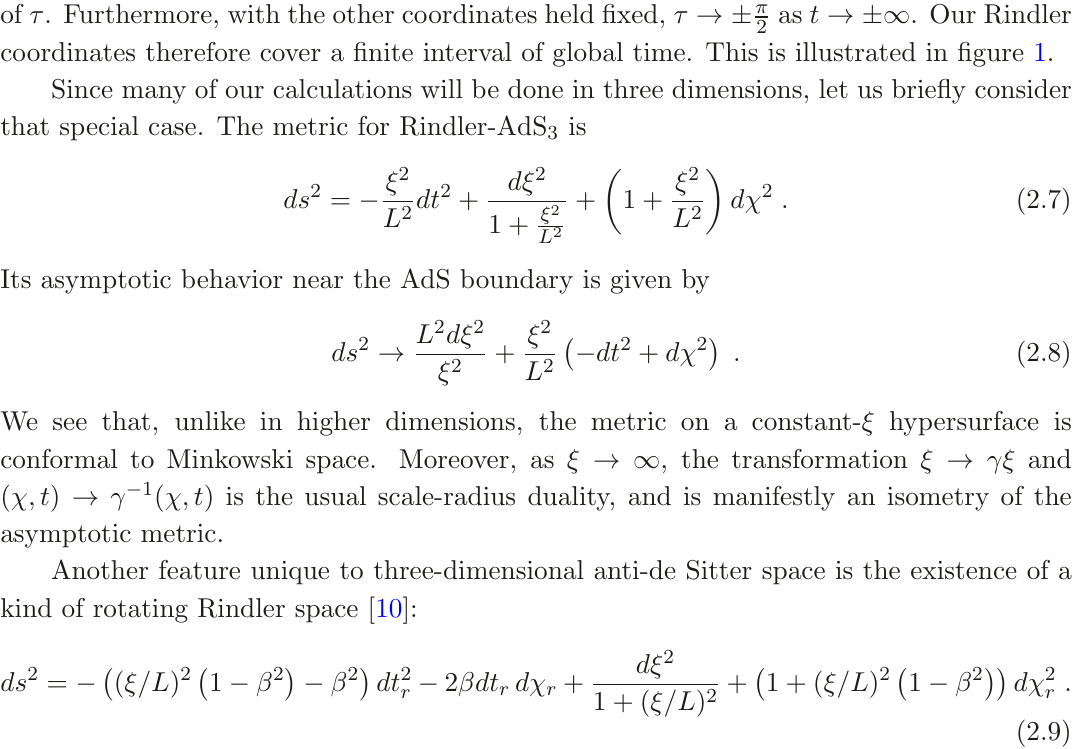
Figure 1 . Geometry of Rindler-AdS d +1 space. A surface of constant ξ is a R τ and ρ are the time and radius in global coordinates; except at ρ = 0 each point in the interior corresponds to a S d − 2 . The Rindler-AdS region extends only up to τ = AdS. The arrow on the right points in the direction of ∂ t , whose orbits are a Rindler observer’s worldline; the arrow is reversed for the antipodal observer. One copy of the CFT lives on the boundary within the region shown in